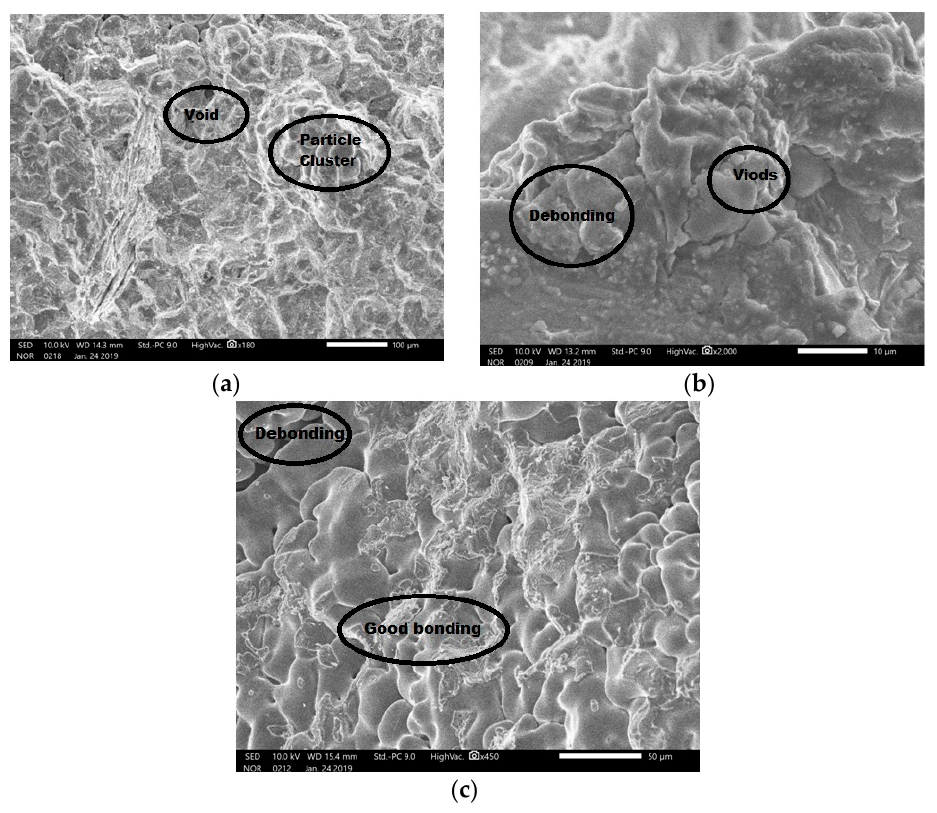
Figure 5. SEM images of ( a ) SP1, ( b ) SP2 and ( c )